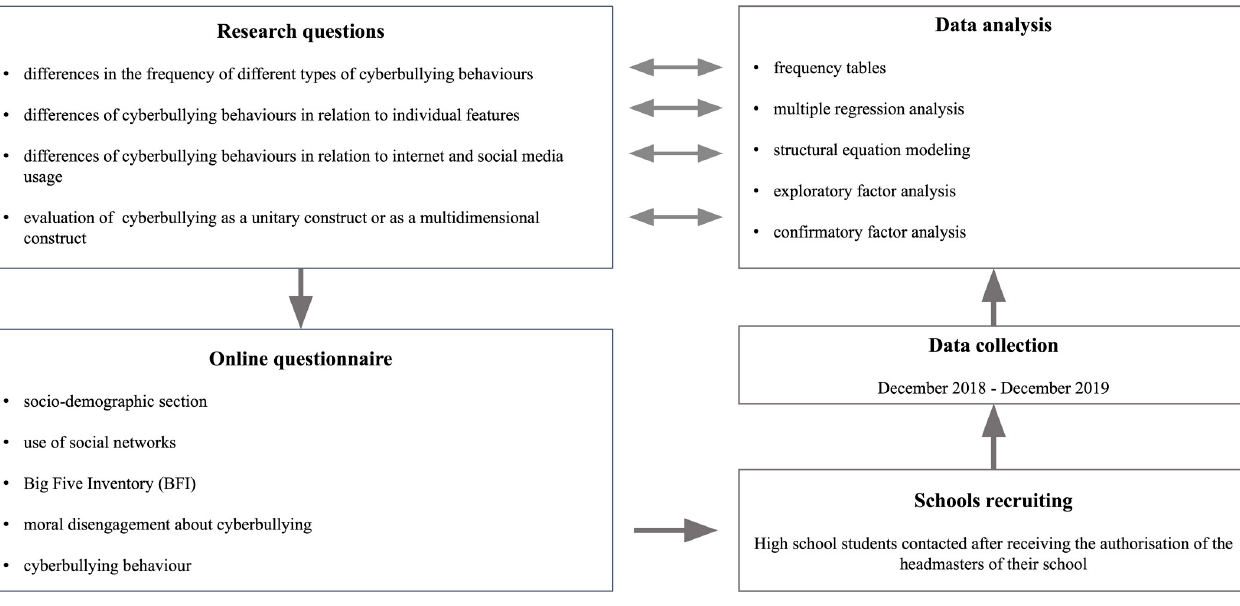
Fig 1. Visual summary of the